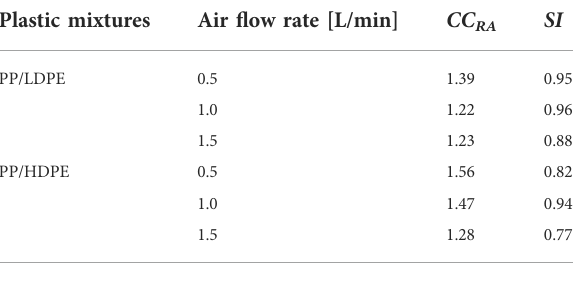
TABLE 1 Reverse apparent concentration criterion ( CC RA ) of each plastic mixtures (i.e., PP/LDPE and PP/HDPE) and sharpness index ( SI ) of reverse hybrid jig separation experiments without bubble generation during pulsation at air fl ow rate (i.e., 0.5, 1.0, and 1.5 L/ min) and wetting agent of 0